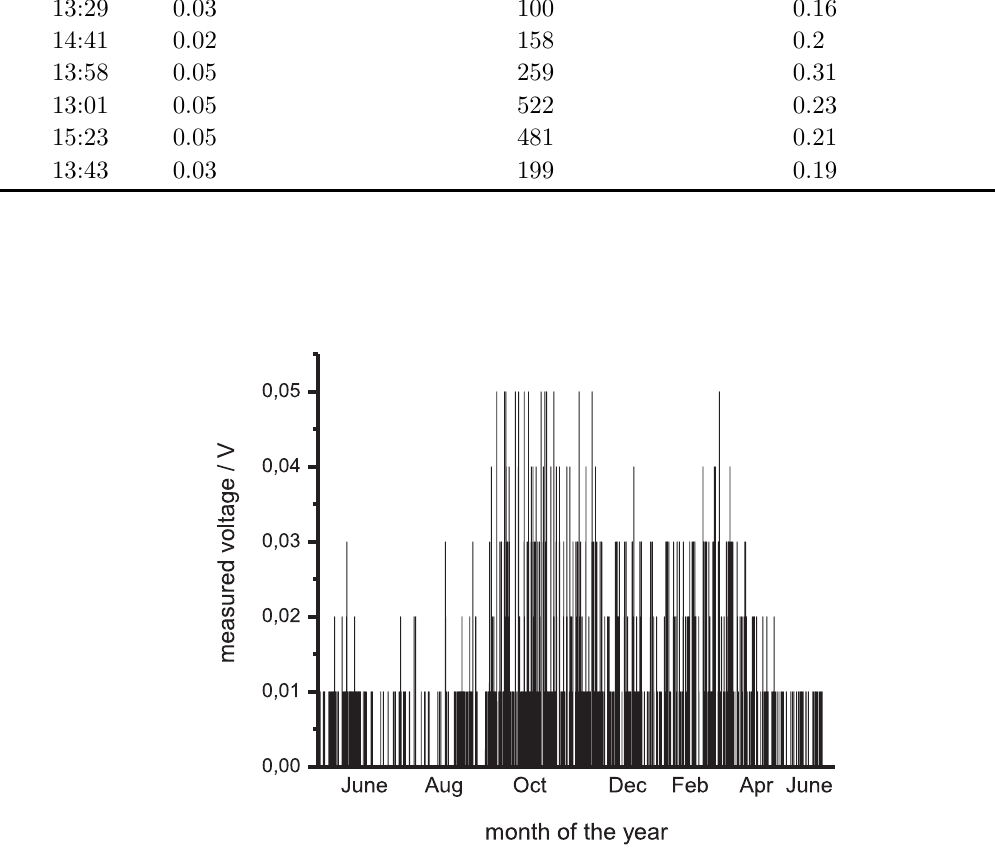
Fig. 4. Voltage values recorded at channel 3 for the Solar Irradiance Sensor (SIS) installed close to the DSSC panel during the measurement period.